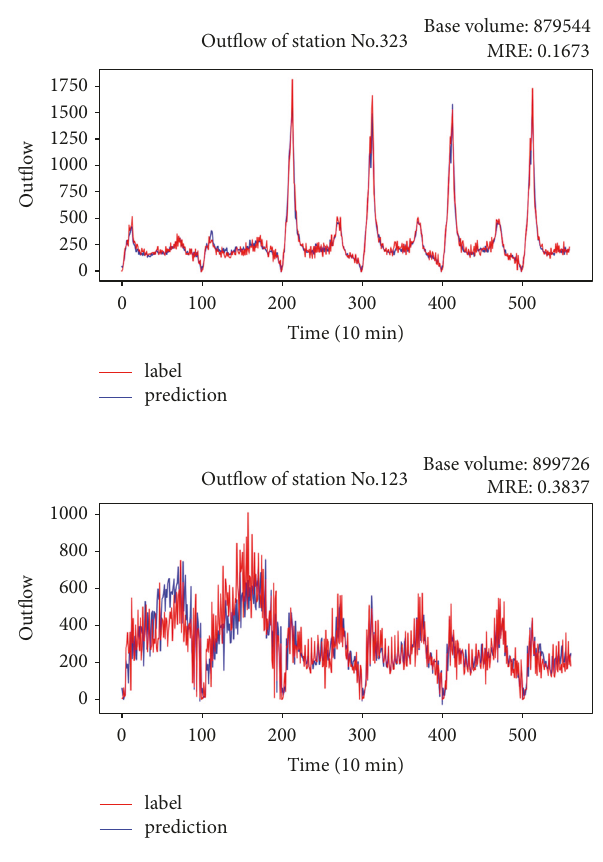
Figure 4: Influence of randomness in